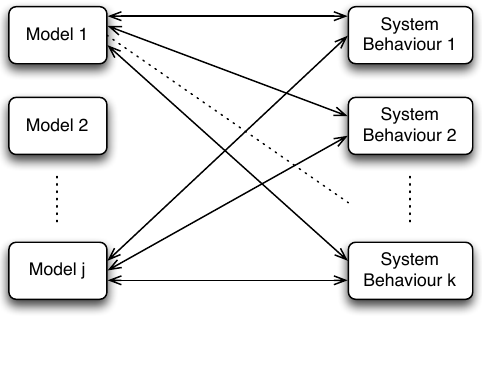
Figure 8. A mapping scheme between models and relevant system